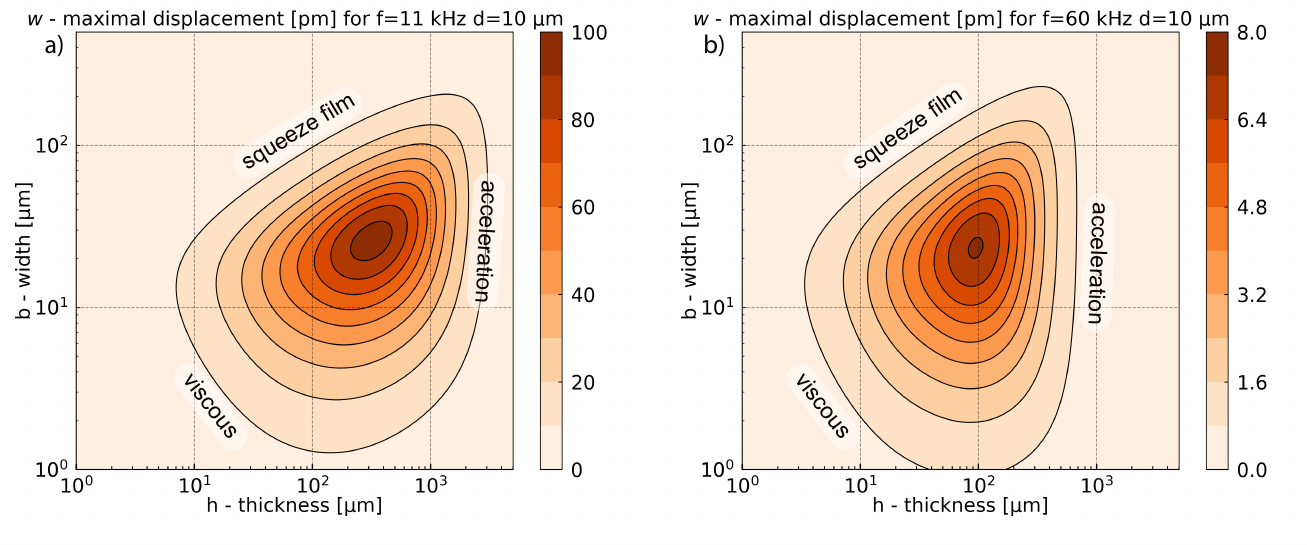
Figure 7. Total displacement versus width and thickness for a cantilever with fundamental resonance frequency equal to 11 kHz ( a ) and 60 kHz ( b ) for a gap between support and cantilever equal to d = 10 µ